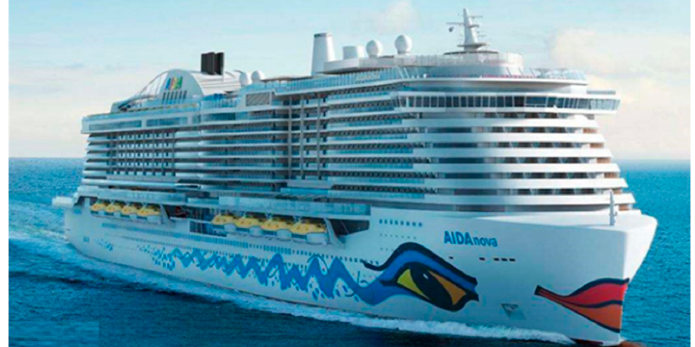
Figure 8. The luxury cruise ship “AIDAnova” [63].